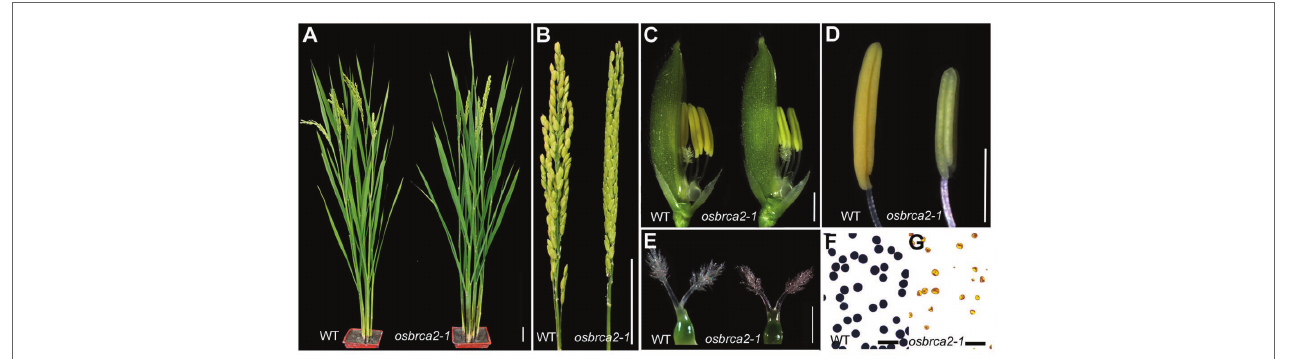
FIGURE 1 | Phenotypic comparison between wild-type and osbrca2-1 mutant. (A) Wild-type and osbrca2-1 plants after heading. (B) Wild-type and osbrca2-1 panicles showing fertile and infertile grains, respectively. (C) Wild-type and osbrca2-1 spikelets after removing lemma. (D) Wild-type and osbrca2-1 pistils at stage 12. (E) Wild-type (left) and osbrca2-1 (right) anthers. (F) I 2 -KI staining of wild-type and (G) osbrca2-1 pollen grains at mature stage. Bars = 5 cm in (A) and (B) , 5 mm in (C) , 1 mm in (D) and (E) , and 100 μ m in (F) and (G)